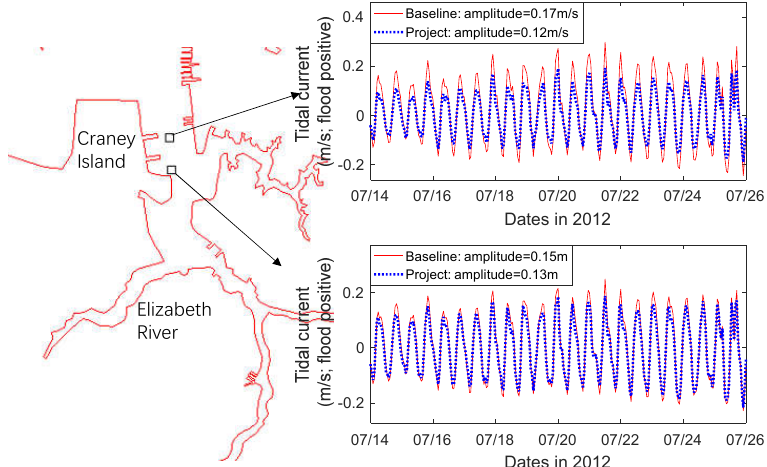
Figure 16. Depth-averaged tidal current at representative stations in the dredged channel near the Craney Island expansion